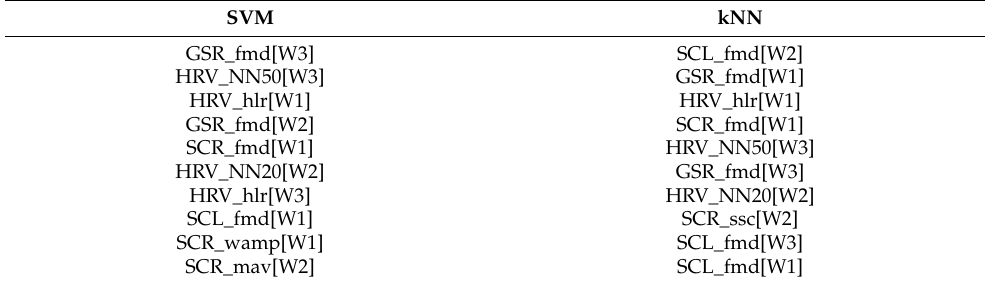
Table 4. Top 10 features selected by the SVM and kNN algorithms for the non-overlapping dataset.